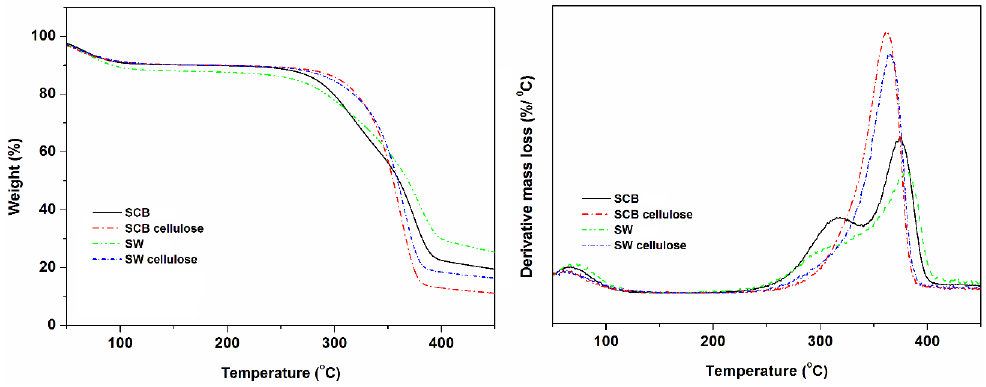
Figure 3. TGA and DTG graphs of SCB, SW, SCB cellulose, and SW cellulose at 11 °C·min −1 .